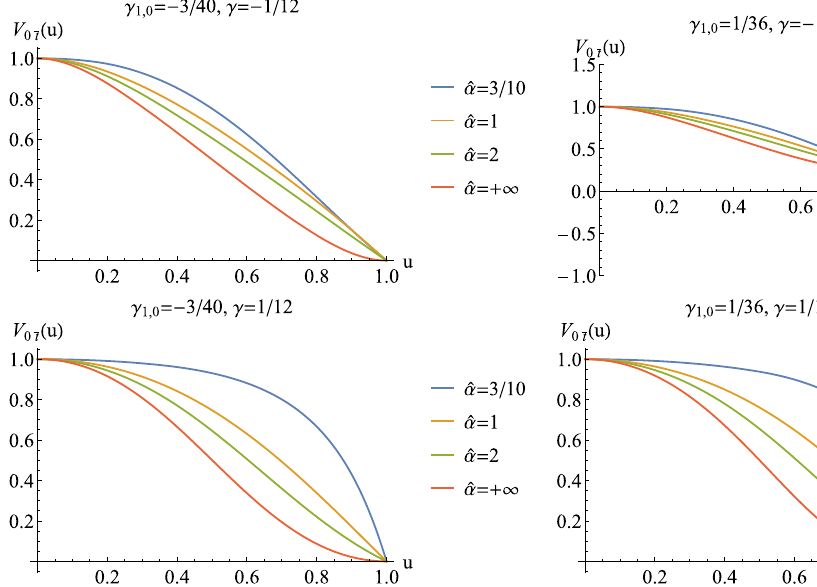
Fig. 19 The potentials V 0 ¯ t ( u ) with representative γ 1 , 0 , γ and ˆ α